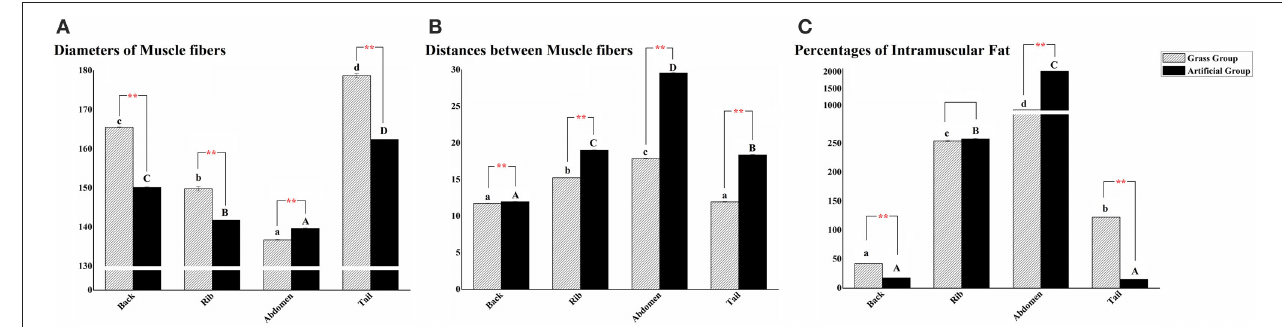
FIGURE 4 | Quantitative results of different positional muscle tissue sections . Quantitative analysis of different positional muscle fiber sections of grass feed C. idellus (dense slash filling) and artificial feed C. idellus (black filling). The muscle fiber diameter statistics of four positional muscle tissues was shown in (A) . The comparisons of distances between muscle fibers and percentages of intramuscular lipid between the two groups were separately presented in (B) and (C) . Vertical bars represent the mean SE. The X axis represent back muscle, rib muscle, abdomen muscle, and tail muscle, respectively. Lowercase (grass feed group) and capital letters ± (artificial feed group) state the significant differences among the four positional muscle tissues sections ( P < 0.05). While the great significance between the two models were marked with ** P < 0.01.